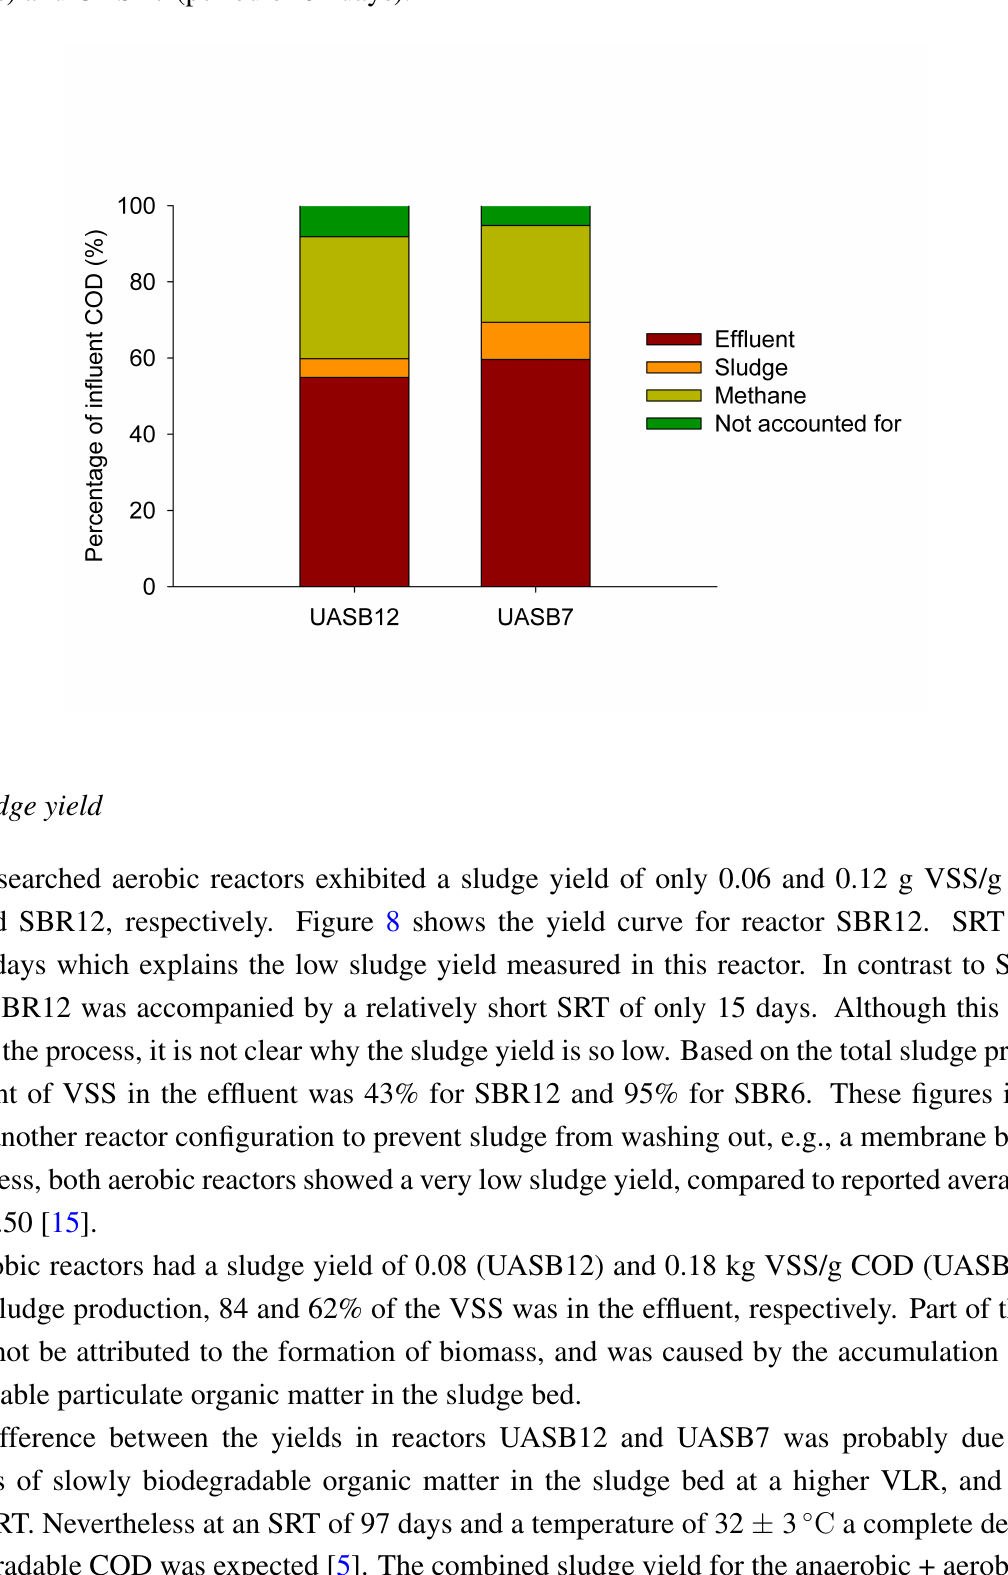
Figure 7. Cumulative COD mass balance on anaerobic reactors UASB12 (period of 168 days) and UASB7 (period of 84